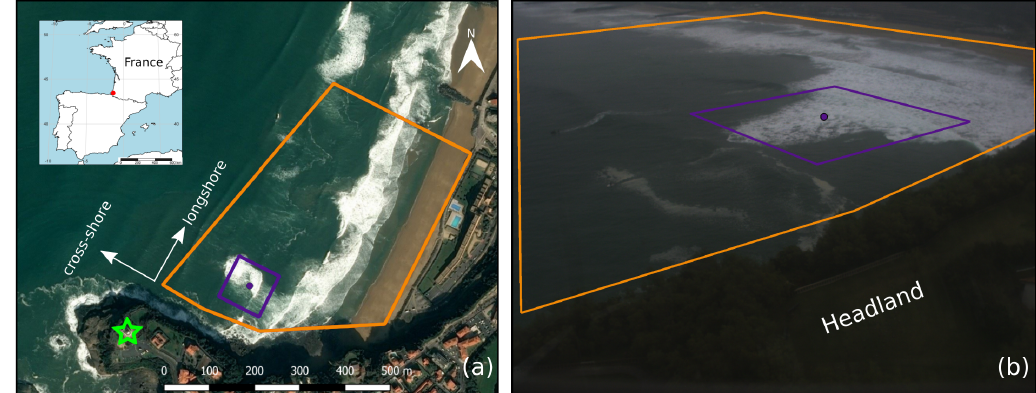
Figure 1. ( a ) Study site of PCA beach, southwestern France. The green star indicates the location of the fixed camera system installed at the top of Biarritz lighthouse near the tip of the headland. ( b ) Example of a snapshot (oblique image) captured by the video monitoring system. The orange and purple polygons show the image-domains used for optical flow implementation. The orange domain corresponds to the drifter experiment area and the purple domain to the ADCP (purple dot) continuous recording within the submerged reef.